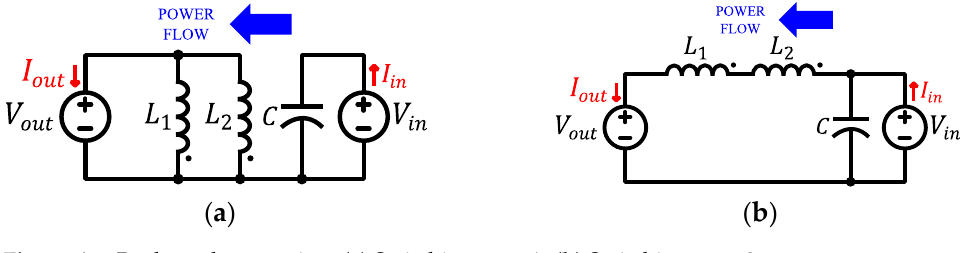
Figure A2. Buck mode operation. ( a ) Switching state 1. ( b ) Switching state 2.